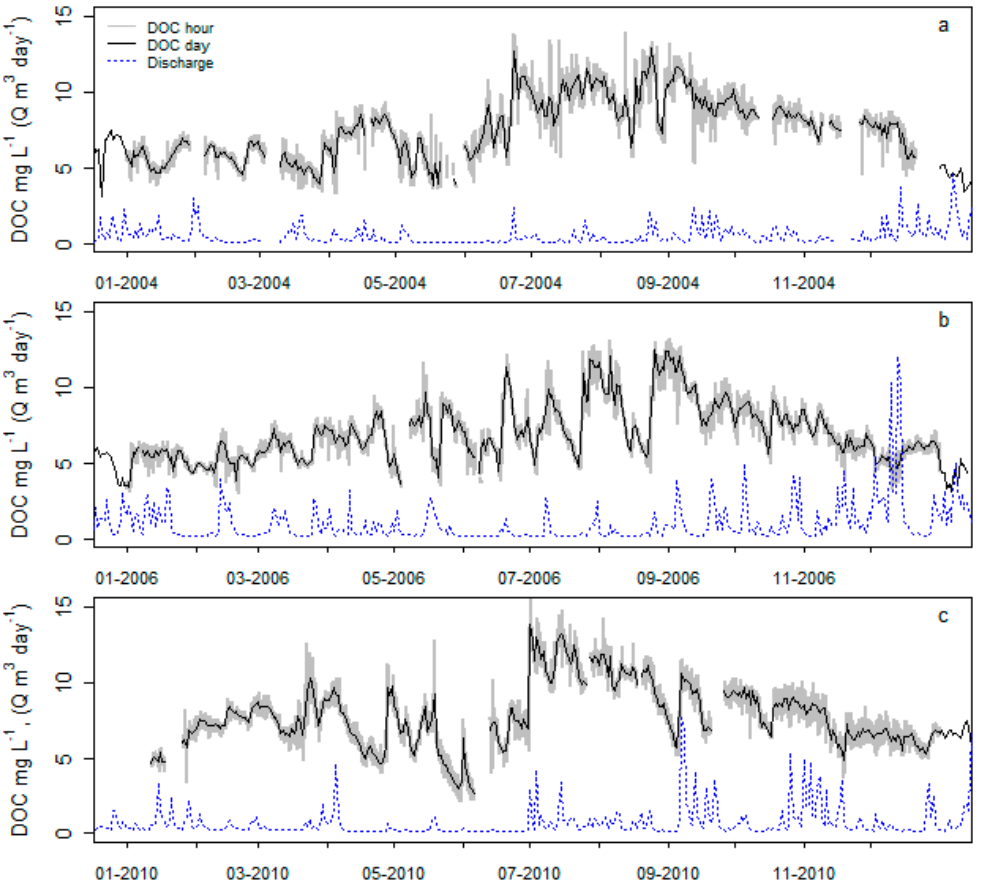
Figure 3. Estimated mean hourly (grey) and daily (black) DOC concentrations (mg L − 1 ) and stream discharge (Q) (m 3 s − 1 ) for the Glenamong River for ( a ) 2004, ( b ) 2006, and ( c ) 2010 for the Glenamong sub-catchment.